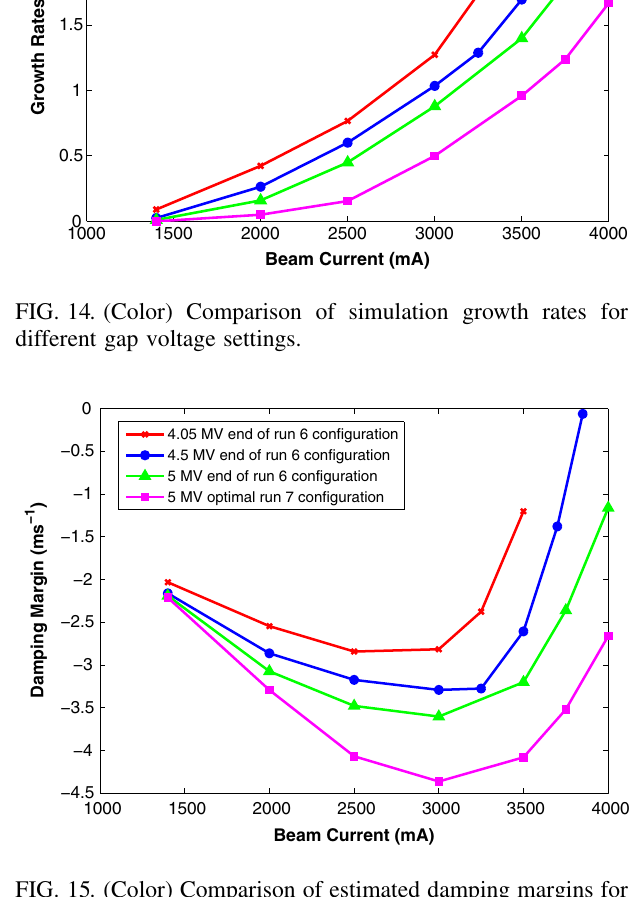
FIG. 15. (Color) Comparison of estimated damping margins for different gap voltage